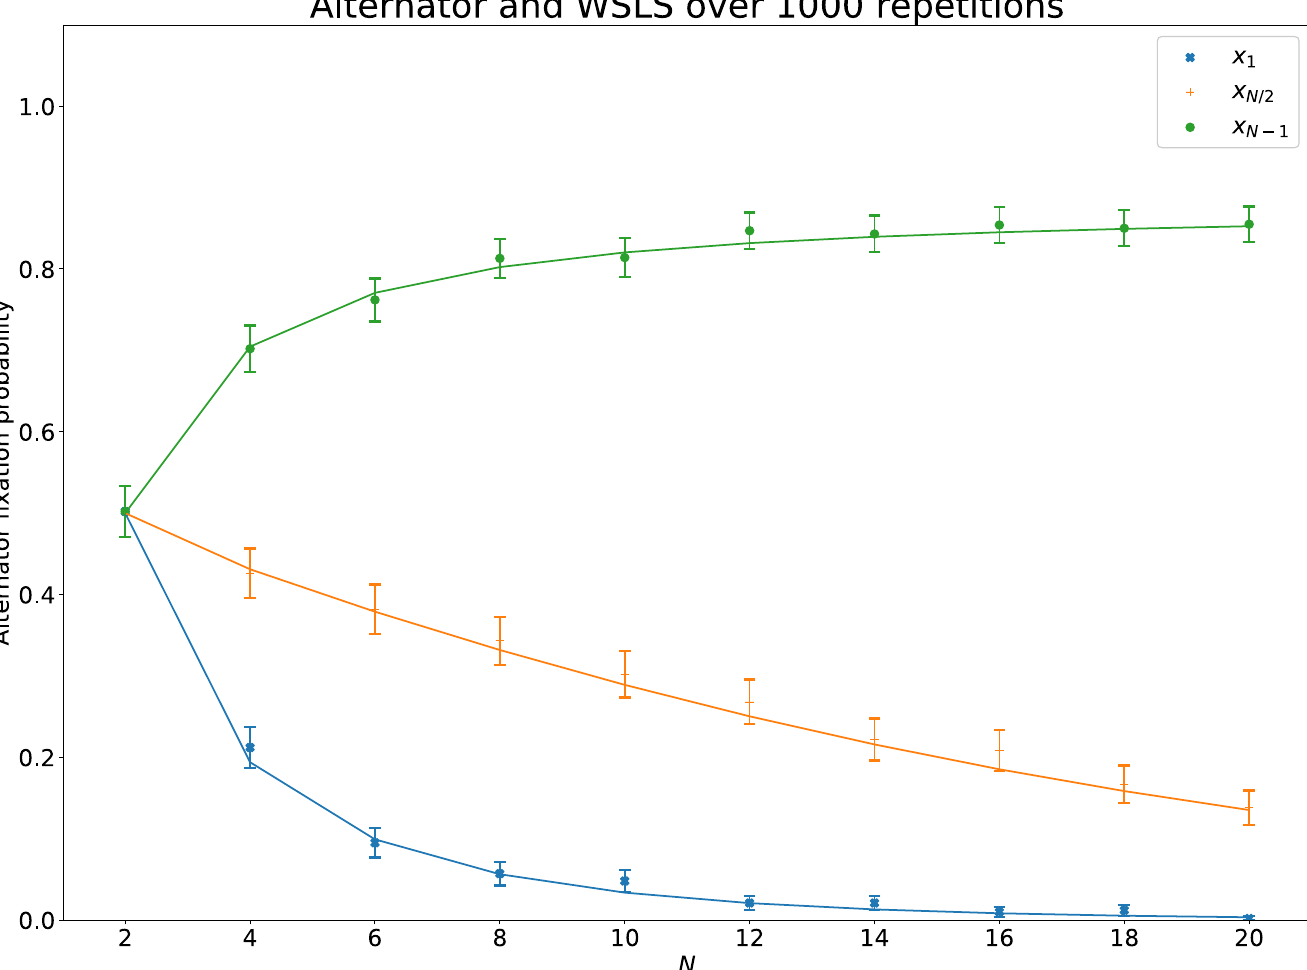
, the middle line (in green and N − 1